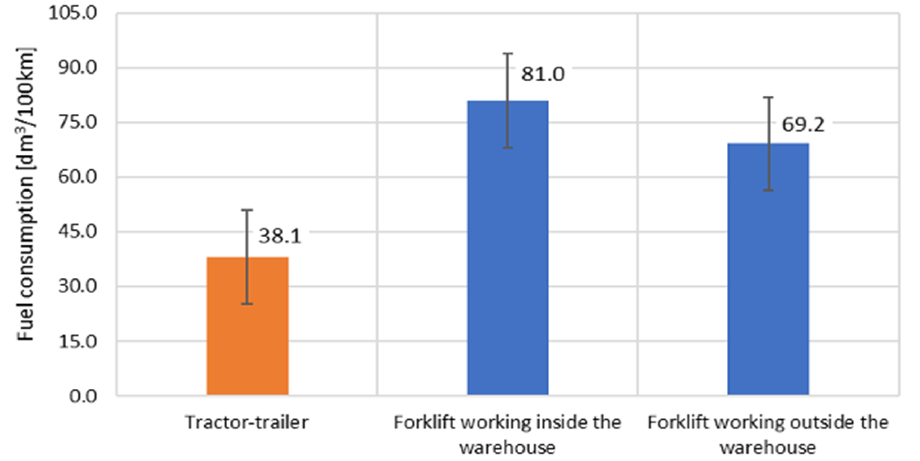
Figure 7. Fuel mileage of the tractor-trailer and the forklift.